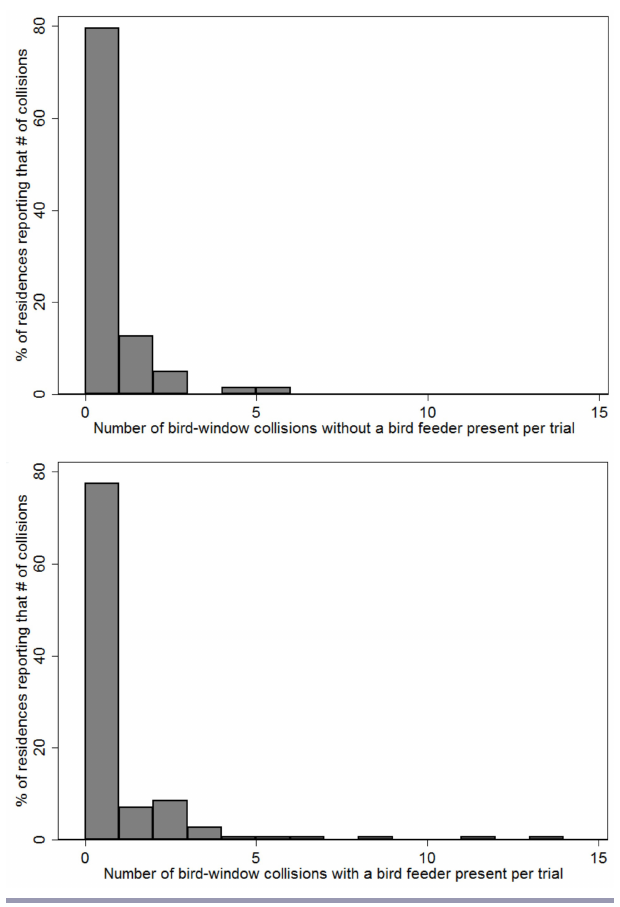
Fig. 1 . Histogram showing percentage of residences reporting a particular number of bird-window collisions during trials with no feeder and trials where the bird feeder was present in front of the window.